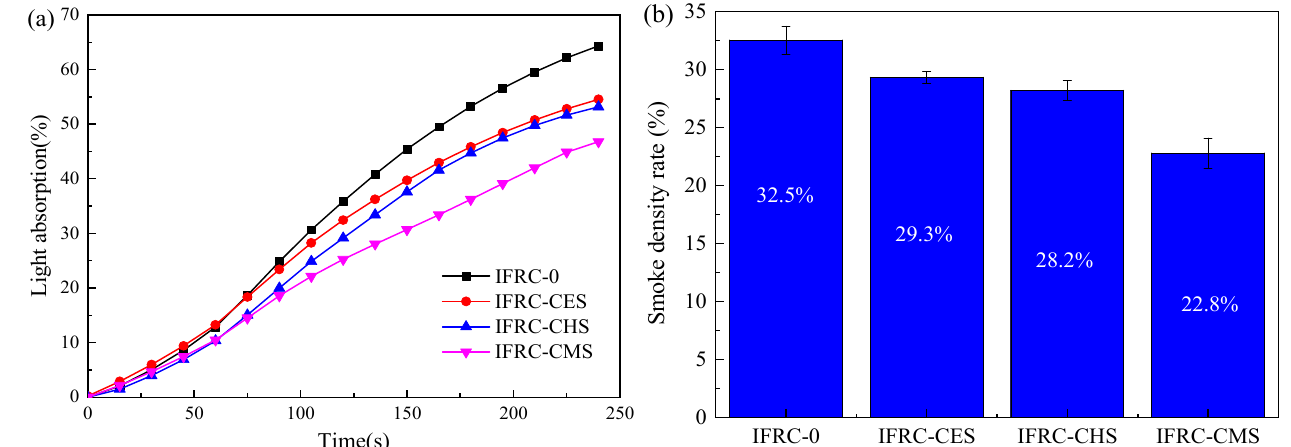
Figure 9. Light-absorptivity curves ( a ) and smoke density rate ( b ) of IFRCs.